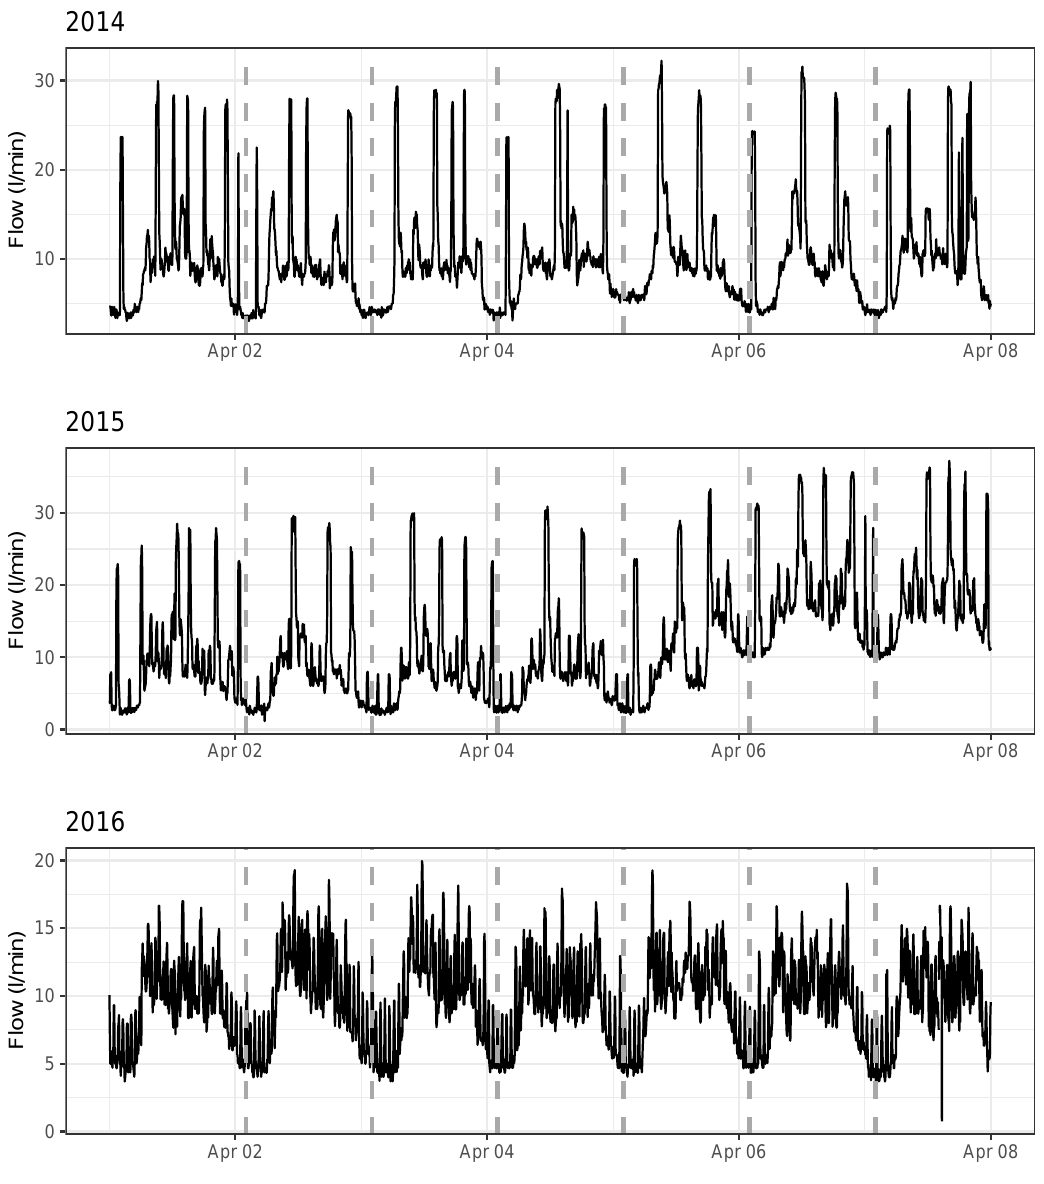
Figure A2. Comparison of the same week of April over the three sampled years (2014, 2015, and 2016) for the suburb